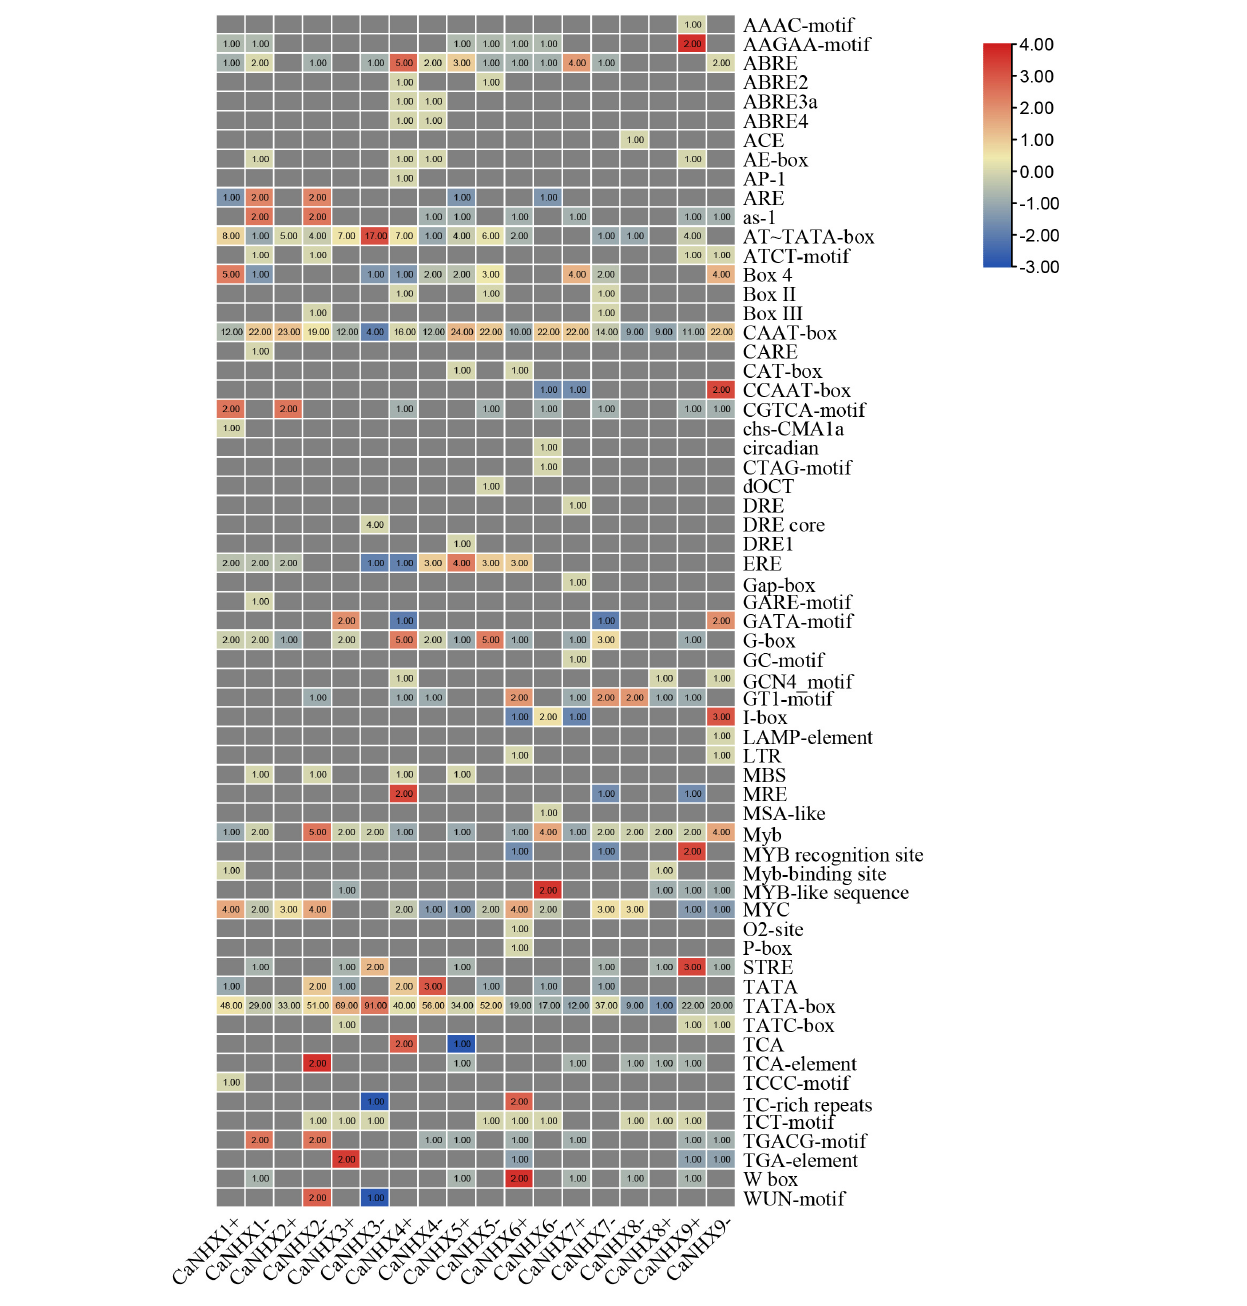
FIGURE 6 | Cis -acting elements of C. annuum CaNHX